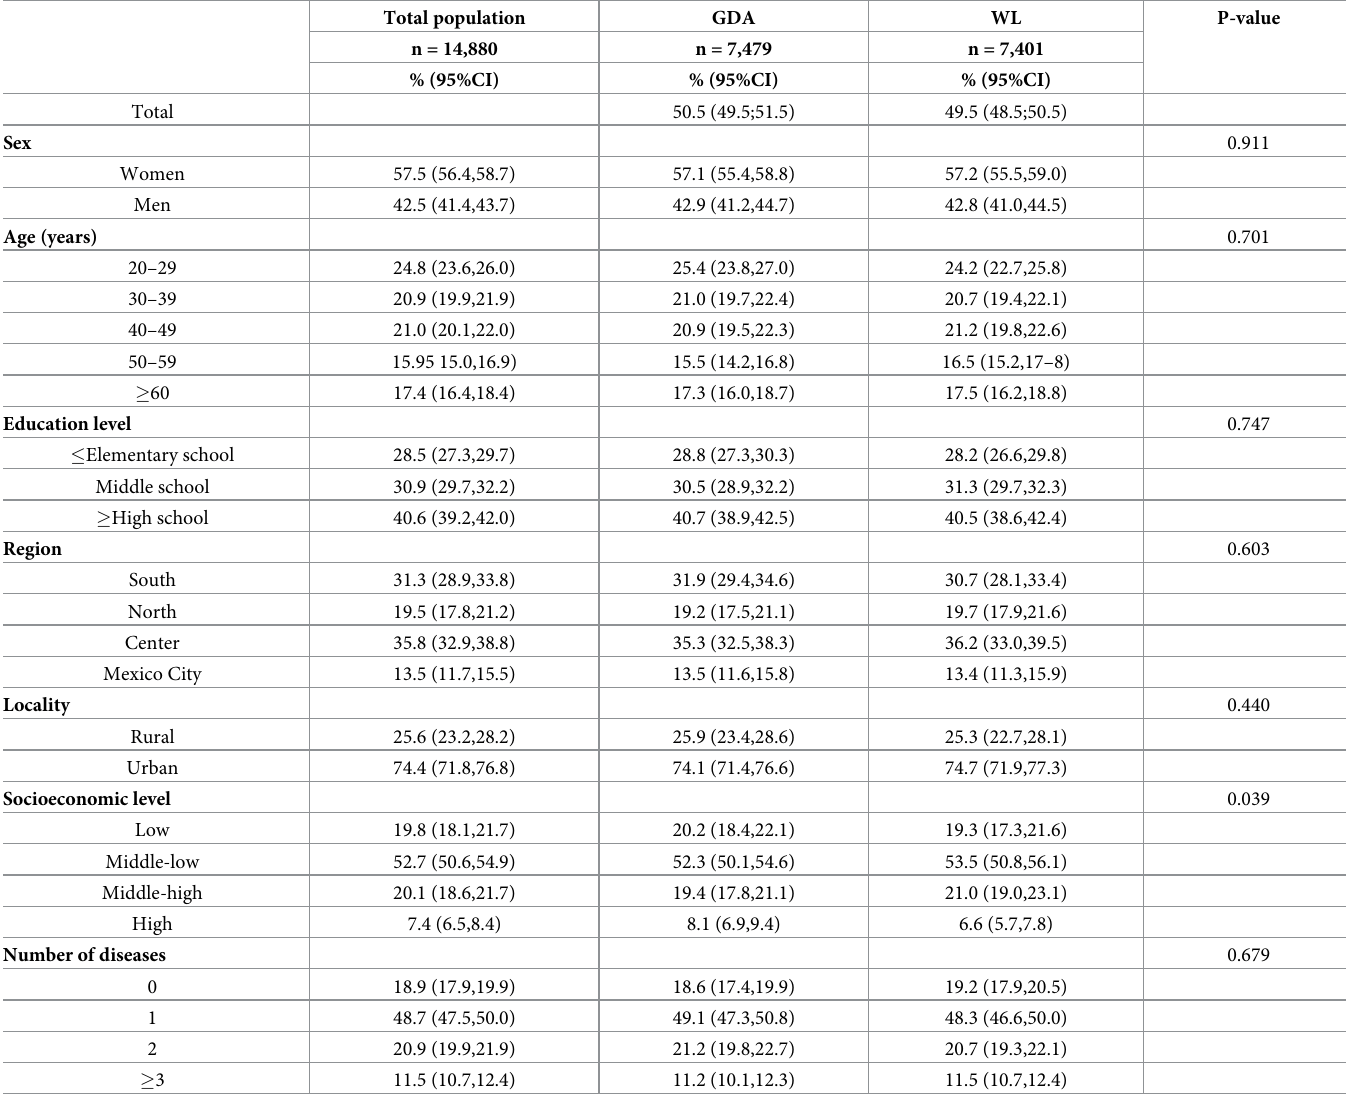
Table 1. Sociodemographic characteristics of the population by type of food labeling. Total